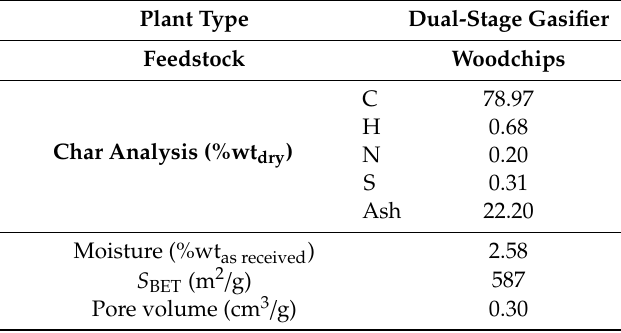
Table 2. Type of gasification technology and main properties of the char selected for the present